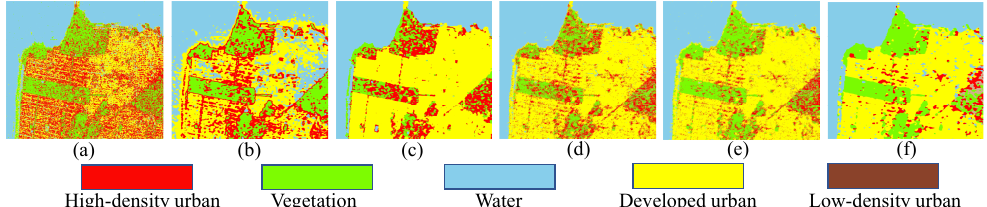
Figure 29. Classification maps of the RS2 dataset. ( a ) 1D-CNN. ( b ) 2D-CNN. ( c ) DenseNet. ( d ) Cap- sNet. ( e ) CapsNet-3. ( f ) Proposed